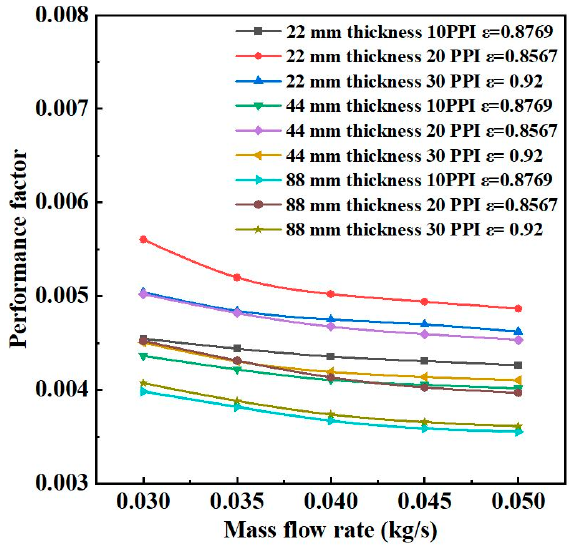
Figure 15. The variation of performance factors for different mass flow rates for different PPI and different thicknesses.